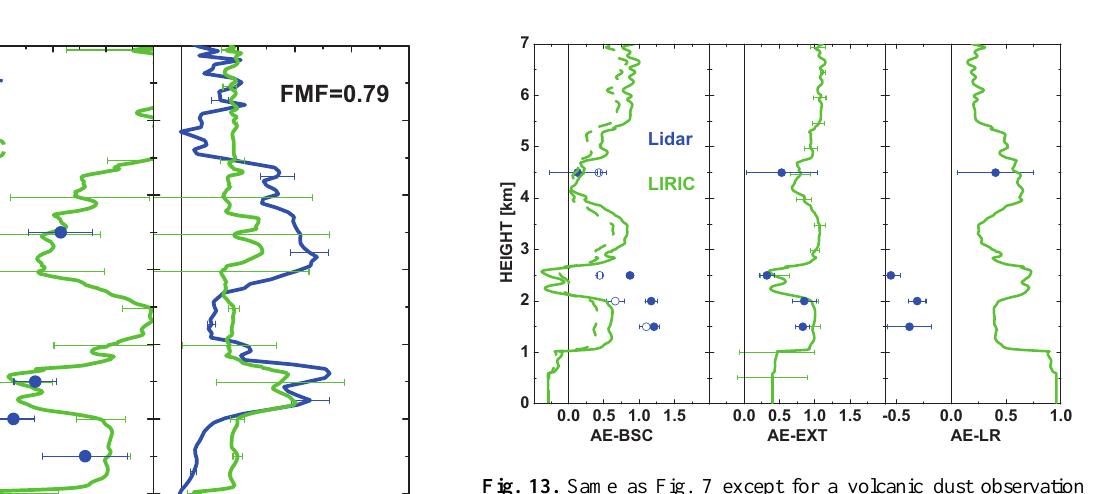
Fig. 13. Same as Fig. 7 except for a volcanic dust observation on 19 April 2010. LIRIC profiles are derived from Fig. 9 (green curves). Raman lidar observations (blue circles) were performed from 13:30 to 15:30UTC. Raman lidar signals are smoothed with window lengths of 660m in the case of extinction coefficients and the lidar ratio.